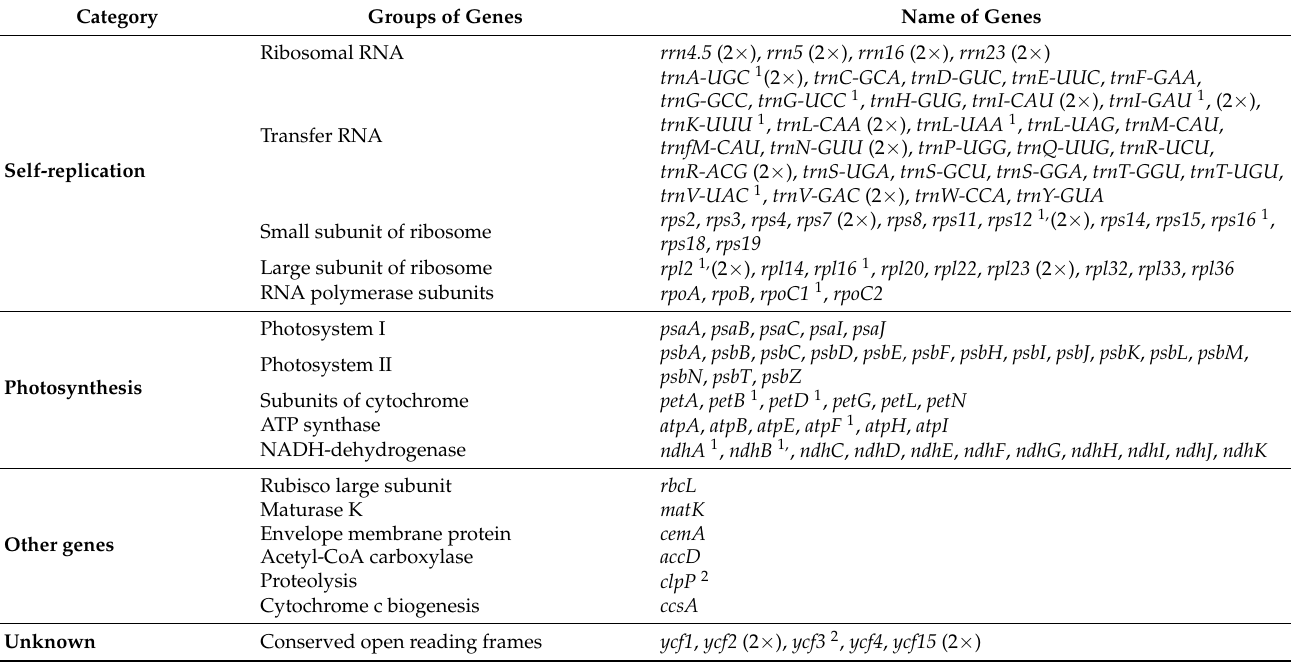
Table 2. Gene composition of the P. fortuneana (red) chloroplast genome.